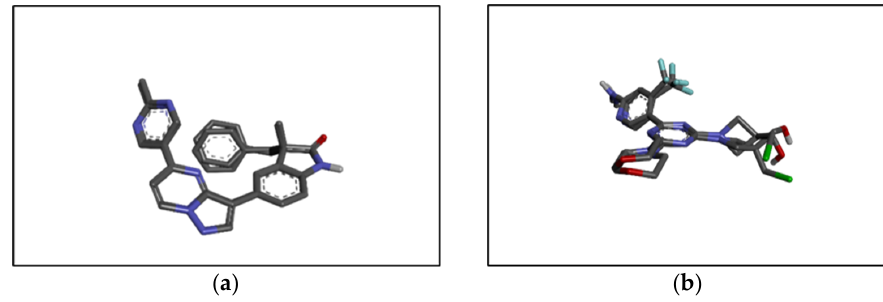
Figure 4. Structure of ( a ) PI3K alpha co ‐ crystallized (from PI3K alpha) vs. docked pose and ( b ) PI3K gamma co ‐ crystallized (from PI3K gamma) vs. docked pose. Table 2. The binding energy of the drugs with PI3K Gamma and PI3K